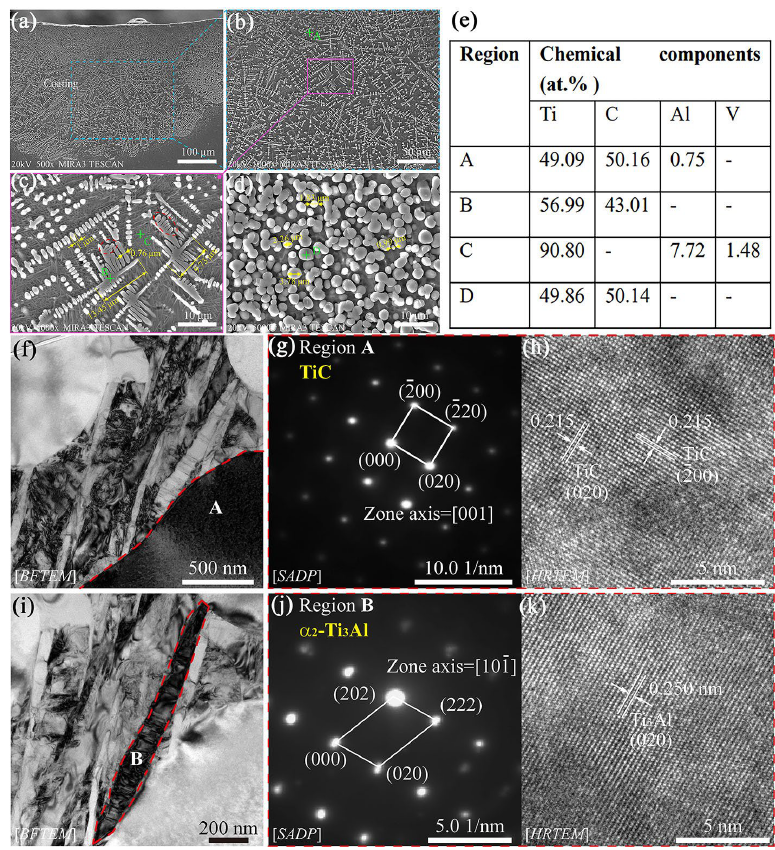
Figure 8. Microstructure of the TiC ceramic cladding layer and TEM analysis: ( a ) cross-sectional morphology; ( b ) low-magnification image and ( c ) high-magnification image of TiC dendrites; ( d ) high-magnification image of TiC granular grains; ( e ) EDS analysis results of TiC ceramic coating (A,B,C,D are the selected areas in ( b – d )); ( f ) BFTEM image of the TiC phase and its corresponding; ( g , h ) SADP and HRTEM images of the TiC phase; ( i ) BFTEM image of the α 2 -Ti 3 Al phase and its corresponding; ( j , k ) SADP and HRTEM images of the α 2 -Ti 3 Al phase (Reprinted from Ref. [138] with the kind permission of